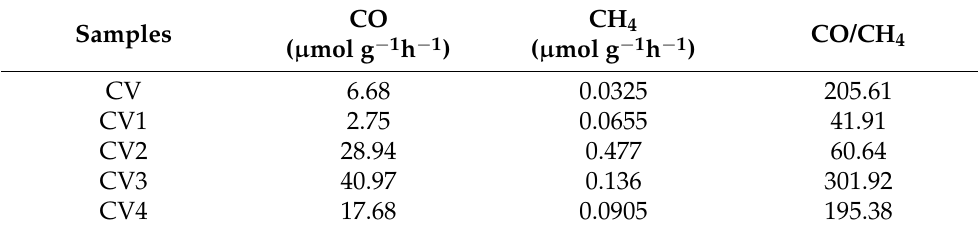
Figure 5. Photocatalytic ( a ) CO yields, ( b ) CH 4 yields for CV, ( c ) C2 products (C 2 H 6 , C 2 H 4 , C 2 H 2 ) evolution amounts in the photocatalytic CO 2 reduction for CV and CV3, ( d ) XRD patterns of CV3 in comparison with CV3’ obtained after photocatalytic reaction.